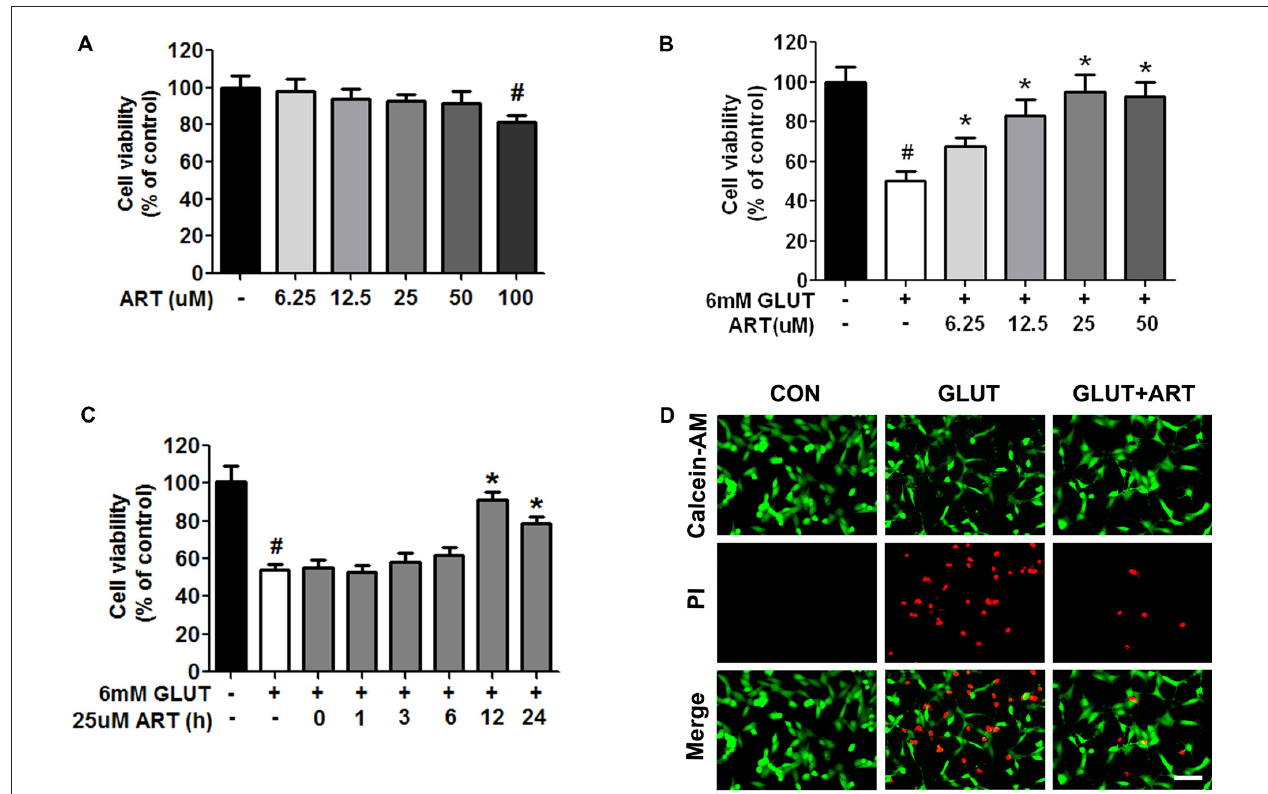
FIGURE 1 | Pretreatment with artemisinin protected HT-22 cells against glutamate-induced cell death. (A) Artemisinin concentration between 6.25–50 µ M did not cause any cytotoxicity in HT-22 cells. (B) Pretreatment with artemisinin for 12 h significantly attenuated glutamate-induced HT-22 cell death in a dose-dependent manner. (C) No protective effect against glutamate-induced toxicity was observed when 25 µ M artemisinin was pretreated less than 12 h. (D) Calcein-AM/PI double staining showed that pretreatment with 25 µ M artemisinin for 12 h attenuated glutamate-induced HT-22 cell death. Scale bar = 100 µ m. # p < 0.05 vs. CON group, ∗ p < 0.05 vs. GLUT